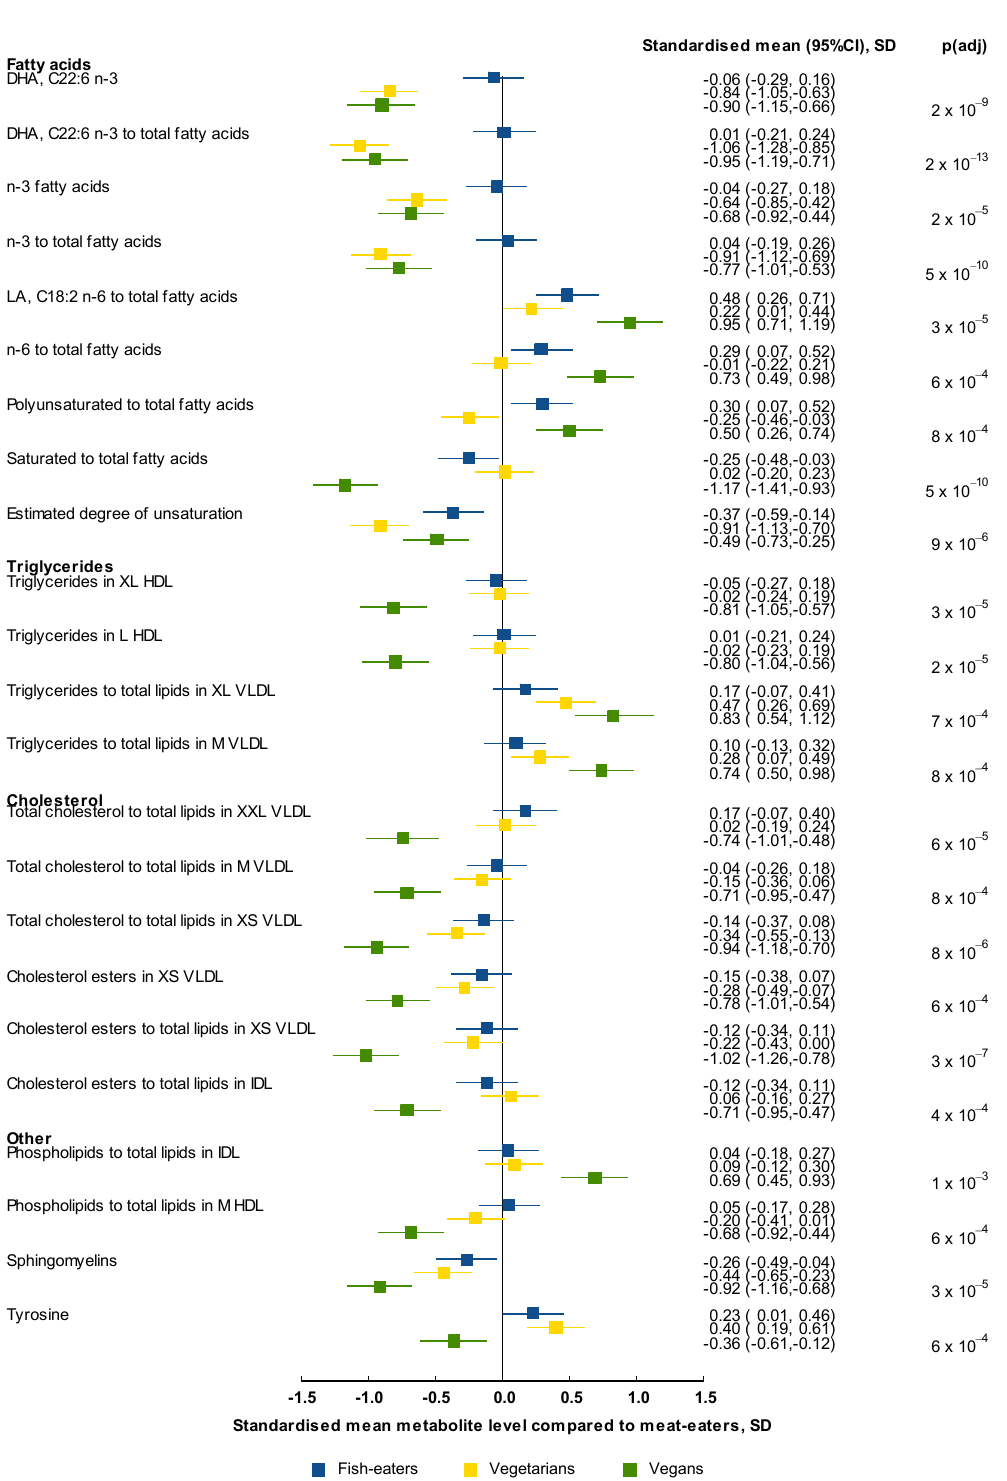
Figure 2. Geometric mean of selected NMR metabolite measures by diet group compared to meat-eaters. Means were standardized to the adjusted means in meat-eaters. p ( adj ) is the p -value after adjusting for multiple testing using a FDR of 0.05 on all 207 metabolite variables, and metabolites with p ( adj ) < 0.001 were included in the figure. All analyses were adjusted for age, BMI, smoking, alcohol, physical activity level, time since last meal at blood collection and time from blood collection to processing. Results for all NMR metabolite measures are shown in Table S3. Abbreviations: CI, confidence interval; DHA, docosahexaenoic acid; HDL, high-density lipoprotein; IDL, intermediate-density lipoprotein; L, large; LA, linoleic acid; M, medium; SD, standard deviation; VLDL, very-low-density lipoprotein; XL, extra-large; XS, extra-small; XXL, chylomicrons and extremely